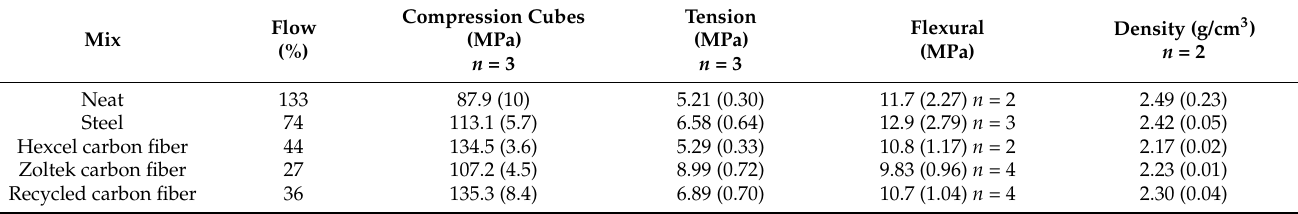
Table 4. Mechanical properties of different concrete mixes.